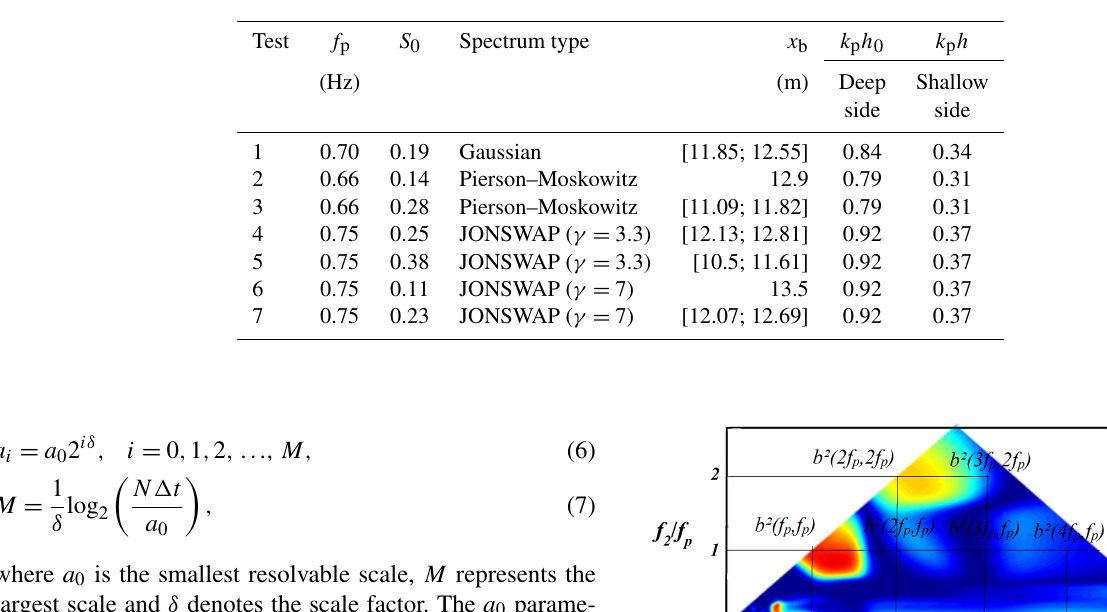
Table 1. Wave train key parameters.